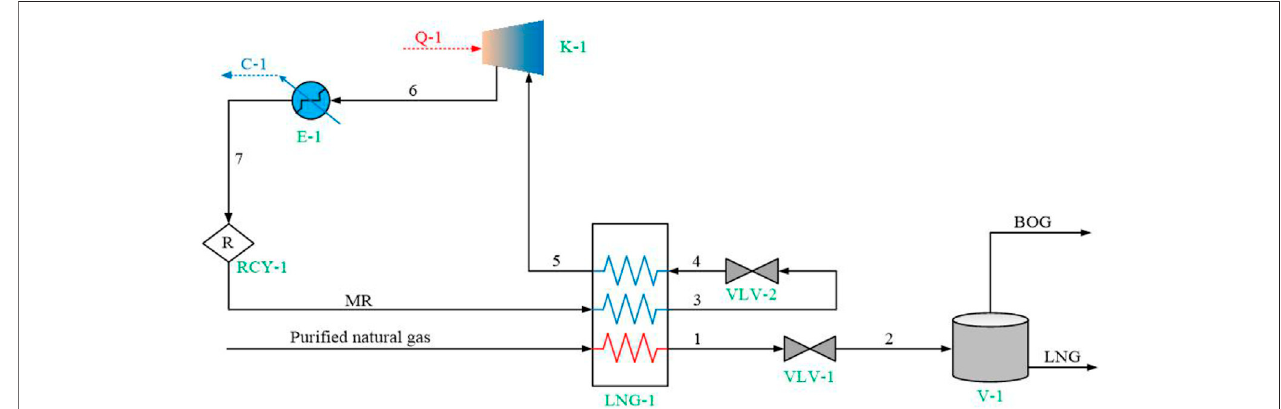
FIGURE 1 | Flowsheet of the SMR liquefaction process in HYSYS.